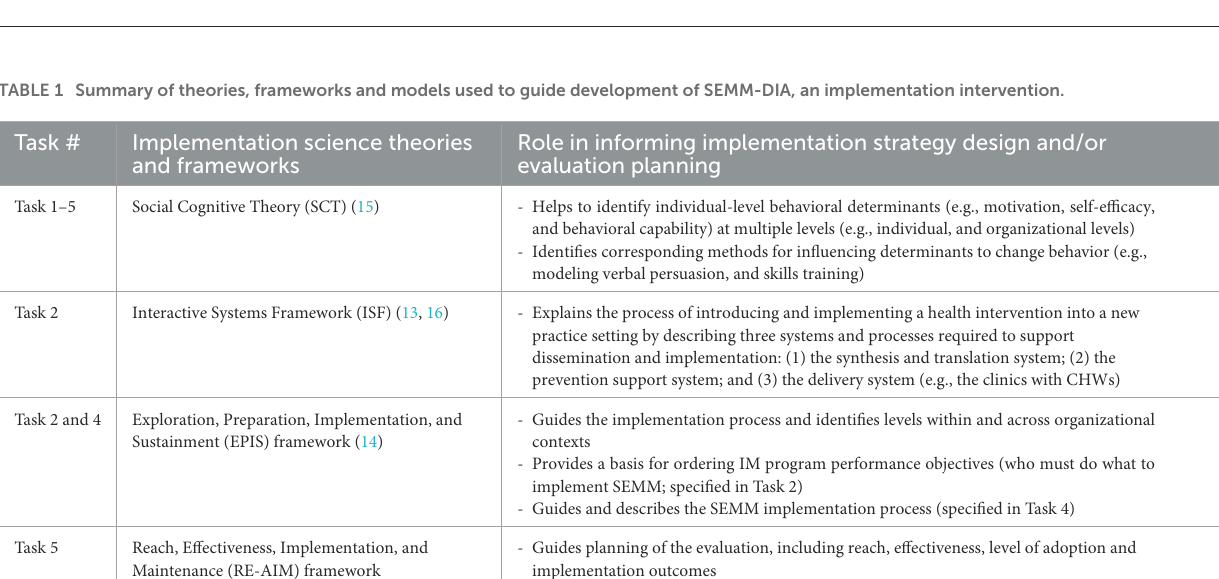
FIGURE1 Implementation Mapping tasks and key deliverables.